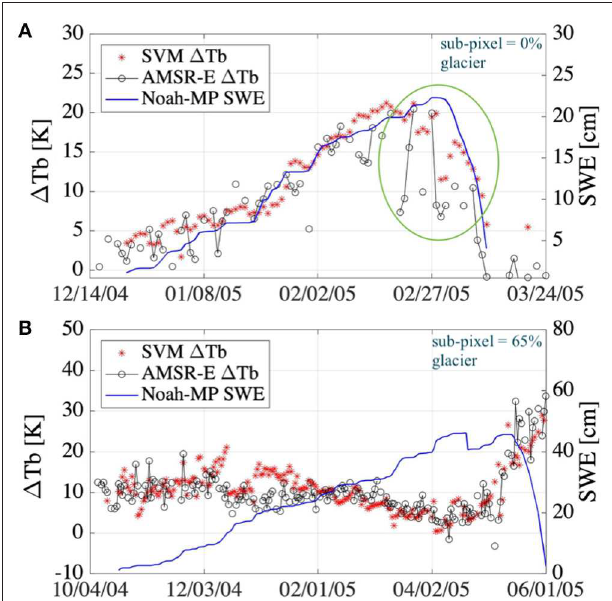
FIGURE 10 | Timeseries of SVM-based predictions of 1 Tb 18.7–36.5 V along with AMSR-E 1 Tb 18.7–36.5 V observations for (A) snow-on-land at a location with no glacier-covered areas and (B) location with significant sub-pixel glacierized areas. Sub-pixel glacier percentage is calculated from the GLIMS dataset (Kargel et al., 2014). The encircled portion in (A) highlights the significant noise in the AMSR-E observations during the ablation period.